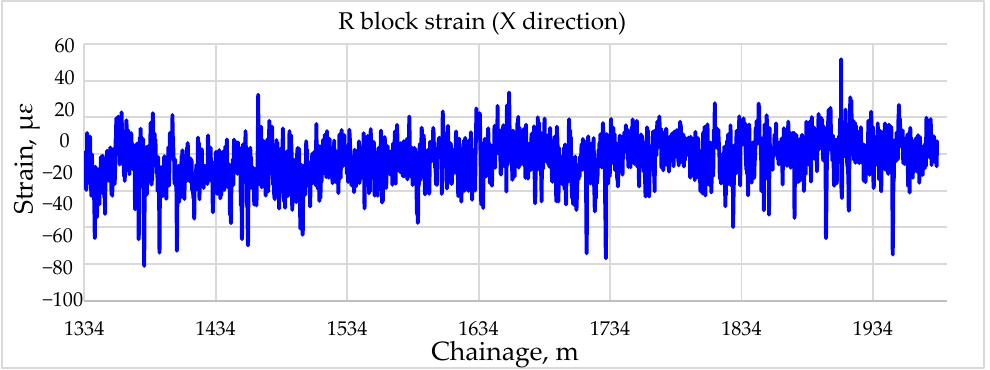
Figure 9. Strain in the Y direction in the B4 raft of the 75-storey block R building.